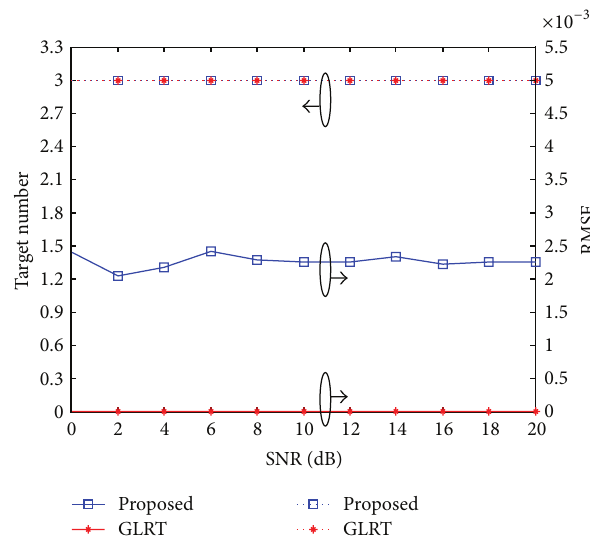
Figure 5: RMSE and the number of estimated SOIs in case A.